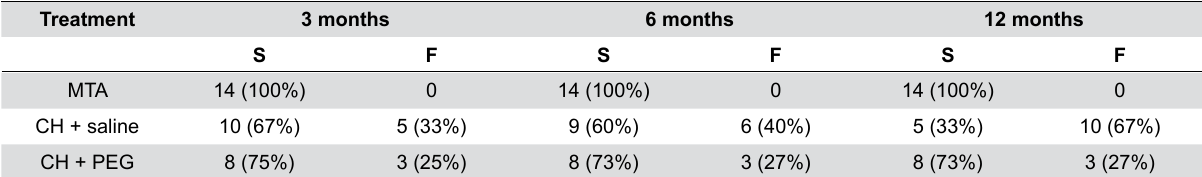
Figure 1- Flow of patients and pulpotomized teeth up to 12 Table 1- Radiographic success (S) and failure (F) rates for the use of MTA, CH+saline and CH+PEG as capping agents in pulpotomies, at 3-, 6- and 12-month follow-up